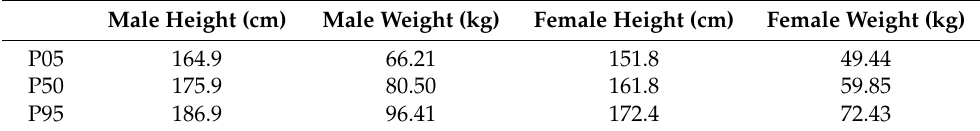
Table 1. Height and weight percentiles of the population according to Huston